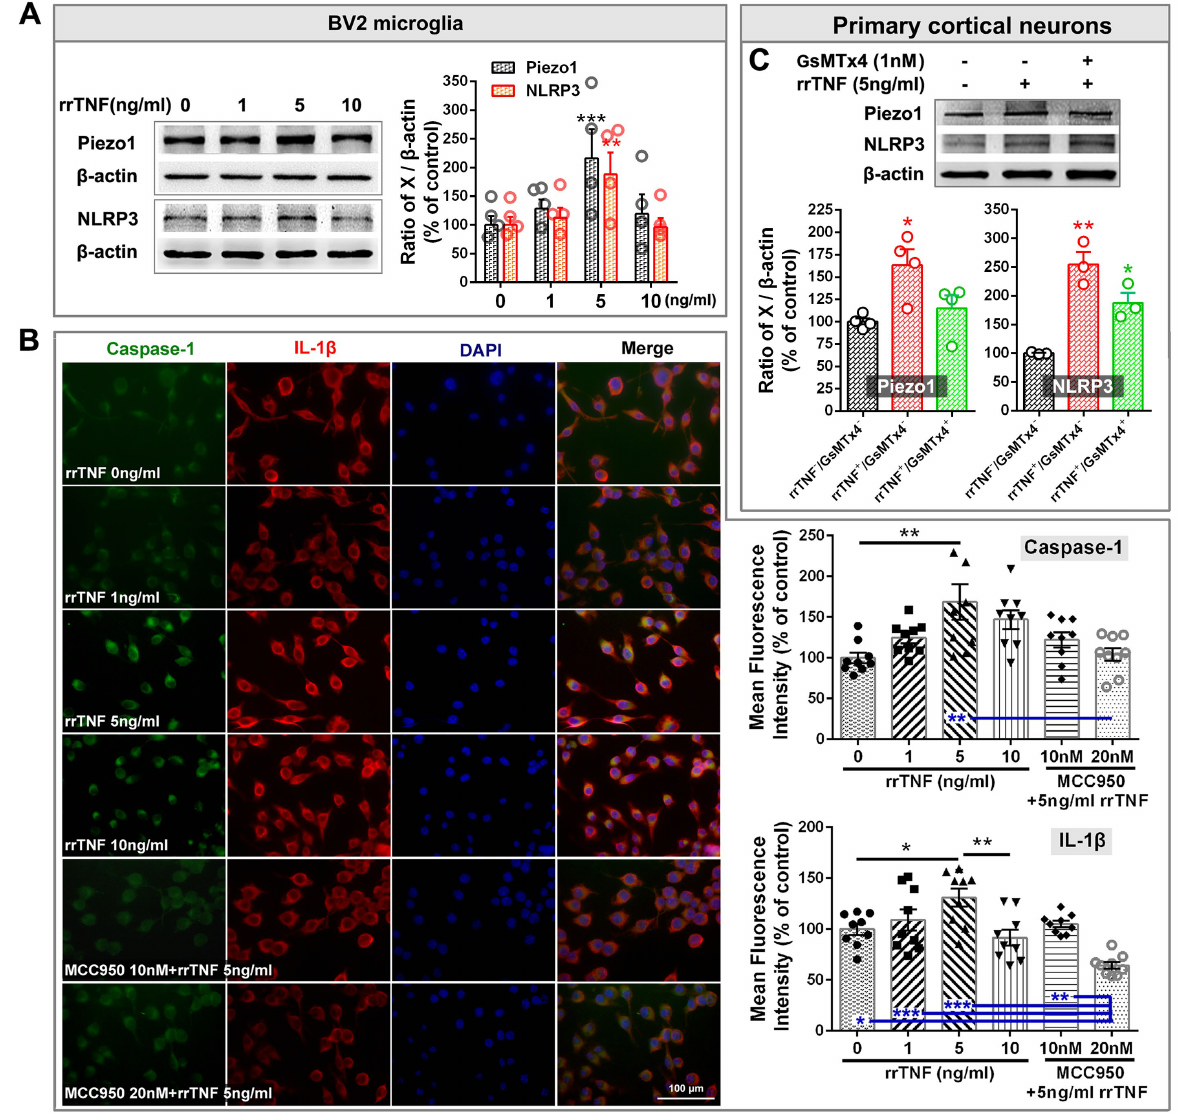
Figure 6. The effect of recombinant rat TNF- α (rrTNF) on the expression levels of Piezo1 and NLRP3 in cellular experiments. ( A ) A representative Western blot showing Piezo1 and NLRP3 protein levels after the treatment of BV2 cells with different doses of rrTNF (0, 1, 5, and 10 ng/mL) is presented on the left. The protein quantifications are shown on the right. ** p -value < 0.01, *** p -value < 0.001 versus the control (0 ng/mL) group (two-way ANOVA). ( B ) Left: Representative double staining showing changes in the immunofluorescence intensities of caspase-1 (green) and IL-1 β (red) following treatment of cultured BV2 cells with different doses of rrTNF (0, 1, 5, and 10 ng/mL) and the effect of the NLRP3 inhibitor MCC950 on the rrTNF-mediated induction of caspase-1 (green) and IL-1 β in BV2 cells. Blue fluorescence is from DAPI. Scale bar = 50 µ m. Right: Quantitative analysis of the fluorescence intensities of caspase-1 and IL-1 β in the different groups. * p -value < 0.05, ** p -value < 0.01 (one-way ANOVA). ( C ) Representative Western blot showing Piezo1 and NLRP3 protein levels following the treatment of the primary ACC neuron culture with rrTNF (5 ng/mL) and the effect of the Piezo1 inhibitor GsMTx4 on these rrTNF-mediated inductions are shown on the top. The quantification results are presented below. * p -value < 0.05, ** p -value < 0.01, *** p -value < 0.001 versus the control (one-way ANOVA). Further in vivo studies showed that SNI-induced NLRP3 colocalized with NeuN (neuronal marker), Iba1 (microglial marker) and GFAP (astrocyte marker), and activated microglia closely clung to NLRP3-IR cell bodies (Figure 7A). Almost all the PV-IR